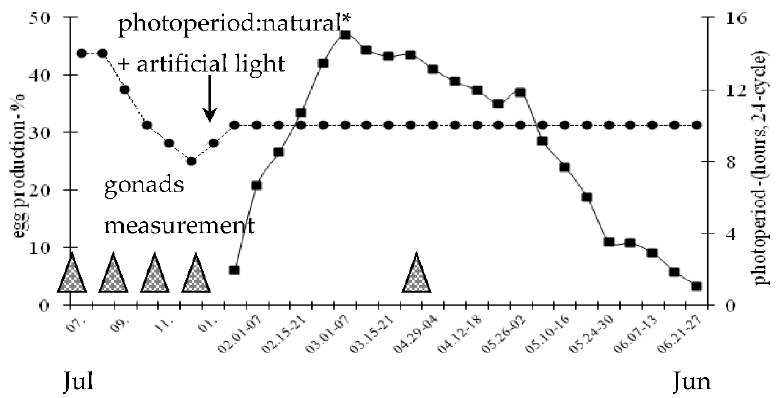
Figure 1. Weekly egg production (mean ratio–%) of 2-year-old Zatorska female geese ( n = 40) and photoperiod conditions during the annual breeding period. * 50°03 ′ N/19°57 ′ E. Egg production was calculated based on individual laying control. Gonads measurement: post-breeding (Jul), non-breeding (Sep), pre-breeding (Nov), onset of laying (Jan), breeding–laying (Apr) stages.